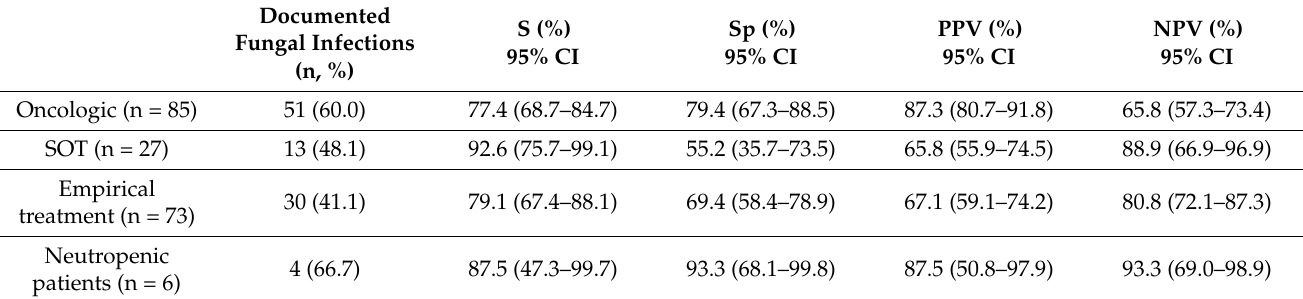
Table 4. Diagnostic performance of serum